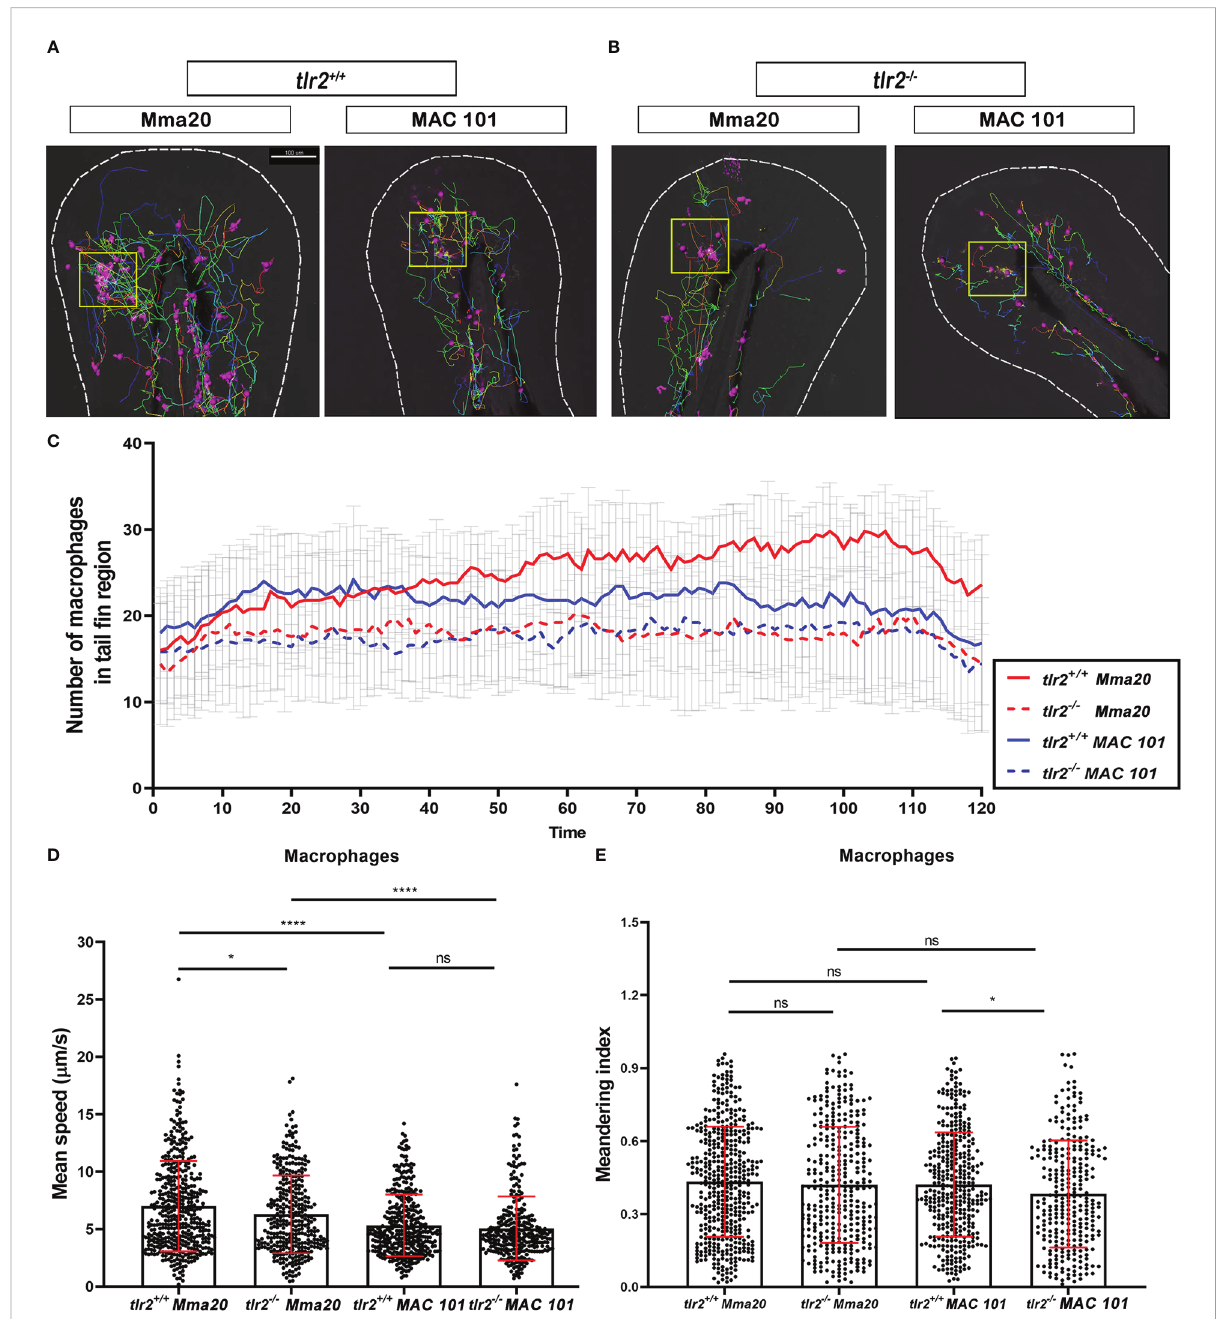
FIGURE 3 Quanti fi cation of macrophages behavior in tlr2 mutant and wild type control larvae after M. marinum Mma20 or M. avium MAC 101 tail fi n infection. (A, B) Representative images of macrophage tracks in tlr2 +/+ or tlr2 -/- larvae with Mma20 or MAC 101 tail fi n infected. The magenta balls represent the tracked macrophages, the yellow box indicates the infected area. (C) The number of recruited macrophages to the tail fi n region upon Mma20 or MAC 101 infection. The curves represent the mean value of the recruited macrophage numbers at different time points. (D) The mean speed of individual tracked macrophages in the tail fi n region. (E) The meandering index of tracked macrophages in the tail fi n region. In (D, E) data (mean ± SD) were combined from three independent experiments with 5 fi sh in each group. Two-way ANOVA with Tukey ’ s multiple comparison test as a post-hoc test. ns, non-signi fi cant; * P < 0.05, **** P < 0.0001. Scale bar: 100 µm; Sample size (n): 447, 343, 372, 290 (D, E)